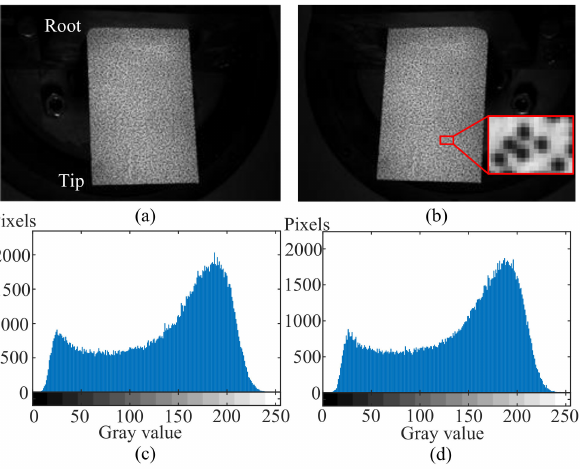
Figure 6. A pair of original reference images from high-speed cameras and the gray-scale histogram of speckle patterns: ( a ) Left image; ( b ) Right image; ( c ) Gray-scale histogram of the ROI in left reference image; ( d ) Gray-scale histogram of the ROI in right reference